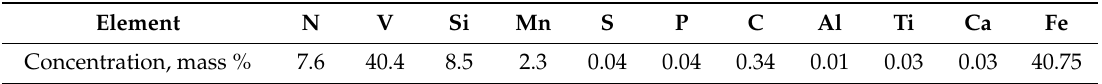
Table 1. Common ferroalloy, Grade FV35N9: Chemical Composition. Element N V Si Mn S P C Al Ti Ca Fe Concentration, mass % 7.6 40.4 8.5 2.3 0.04 0.04 0.34